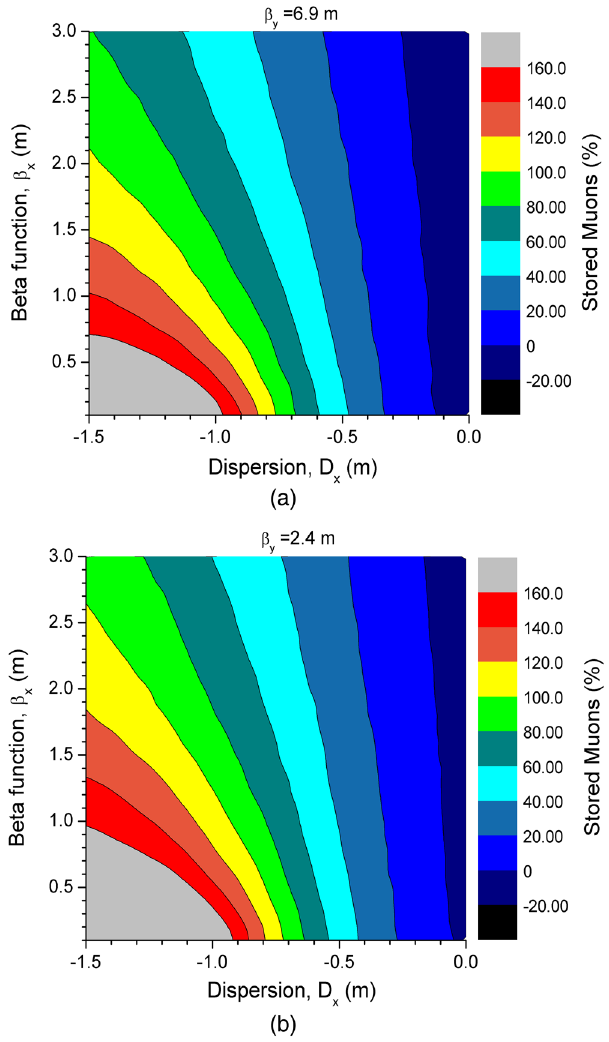
FIG. 6. Color map showing the improvement in performance as a function of horizontal lattice functions at the wedge location. The vertical scale on the right shows the percentage of gained or lost stored muons compared to the no absorber case. All studies assume a single ð C 2 H 4 Þ n 250 mm thick house-shaped wedge at a 162° angle. (a) Performance for the baseline lattice S 1 . (b) Per- formance for the modified lattice S 2 . The wedge is pointing along the horizontal direction with its apex placed near the beam